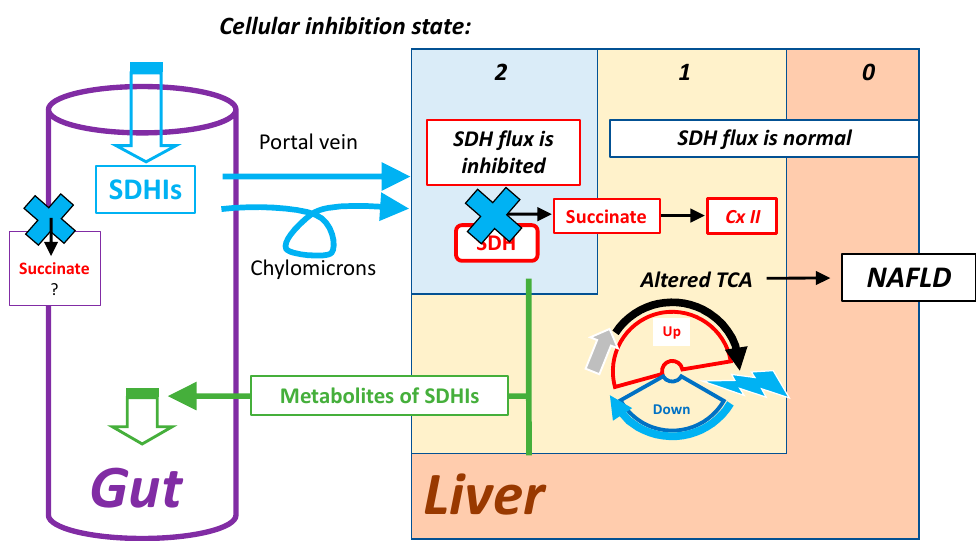
Figure 13. The gastrointestinal tract and liver are the first targets of ingested SDHIs, rest see text.